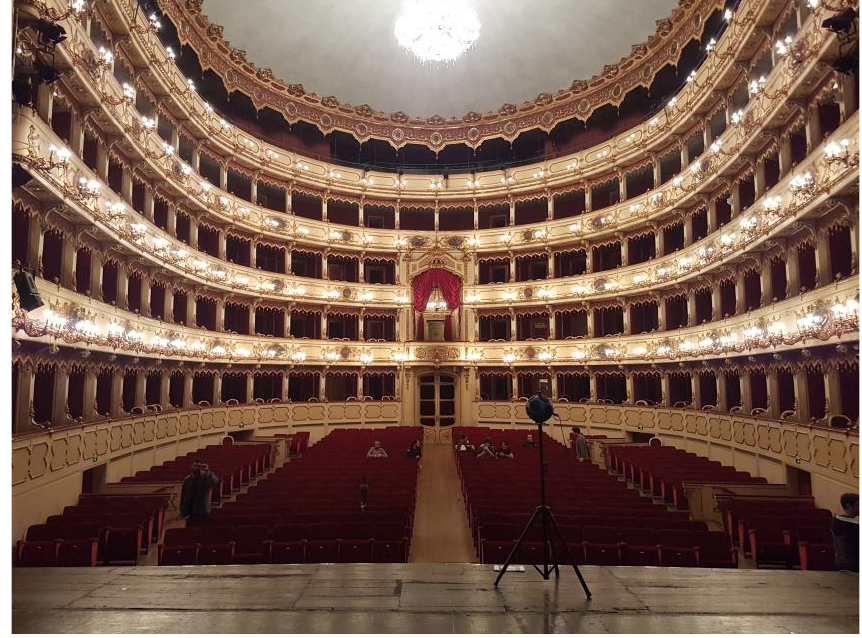
Figure 1. View of the main hall from stage of Ponchielli theater of Cremona [7].